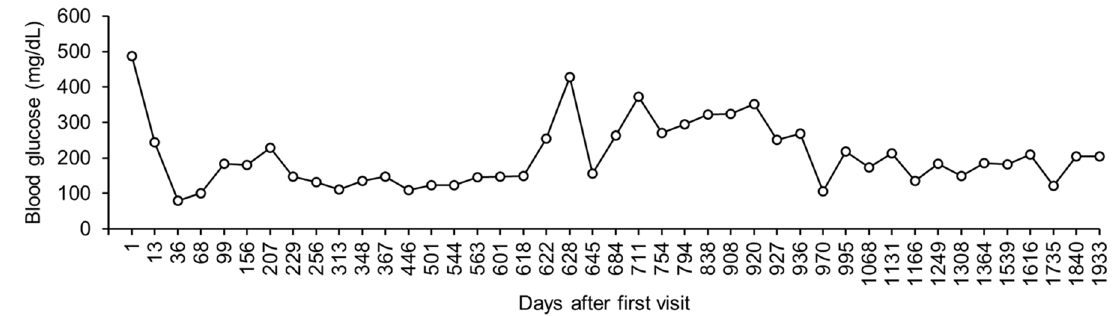
Figure 1. Change in blood glucose level. The blood glucose level was measured at 6 h following the subcutaneous administration of insulin detemir at least once every 10 days. Only the representative values are shown.